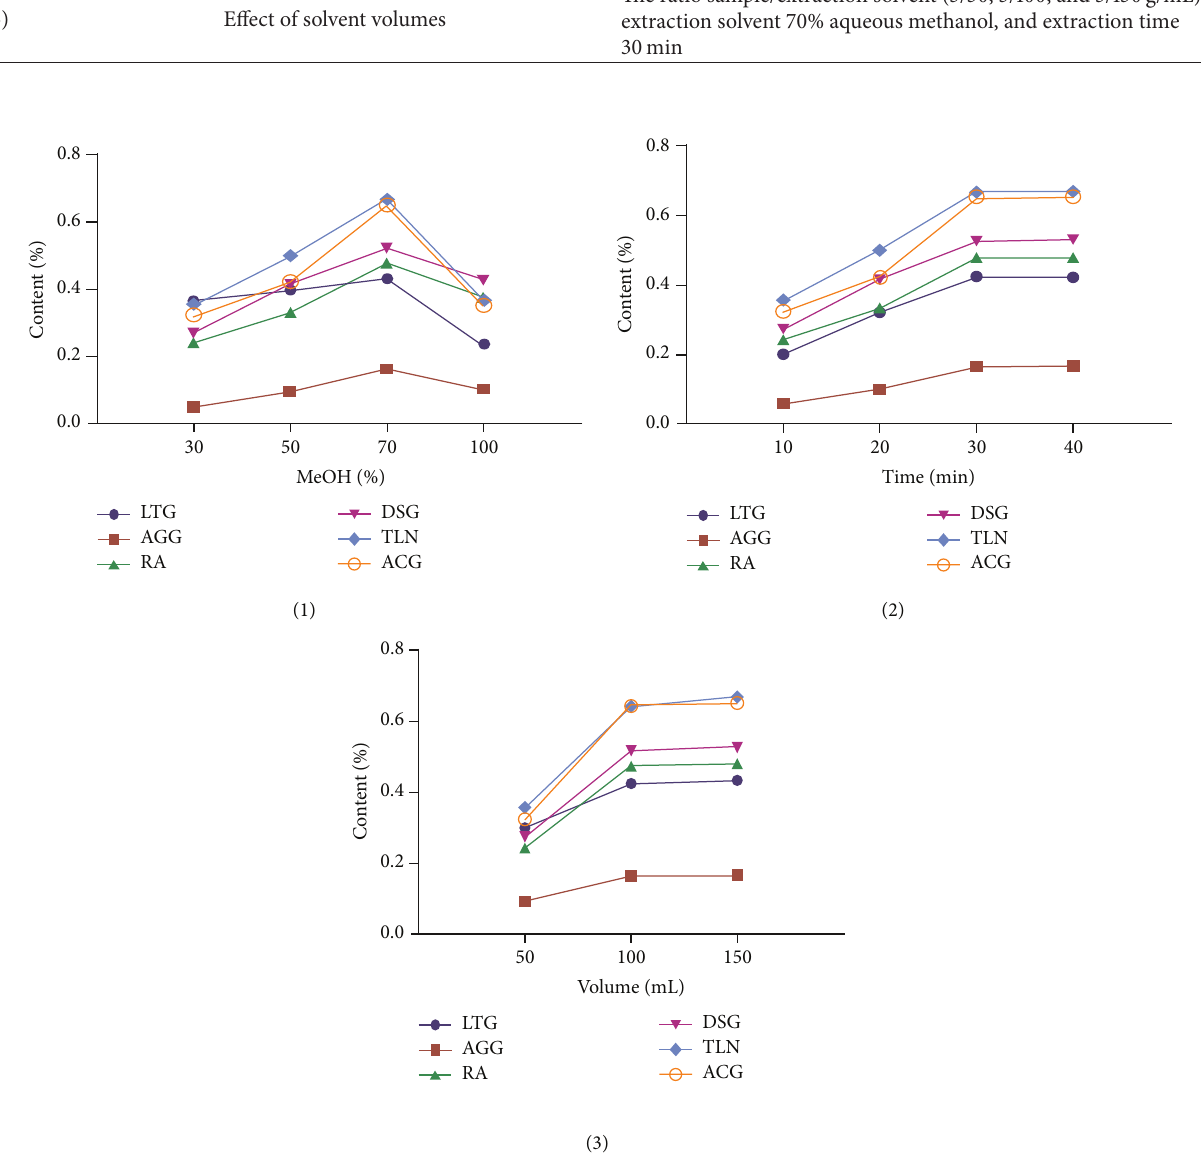
Figure 3: Optimization of extraction